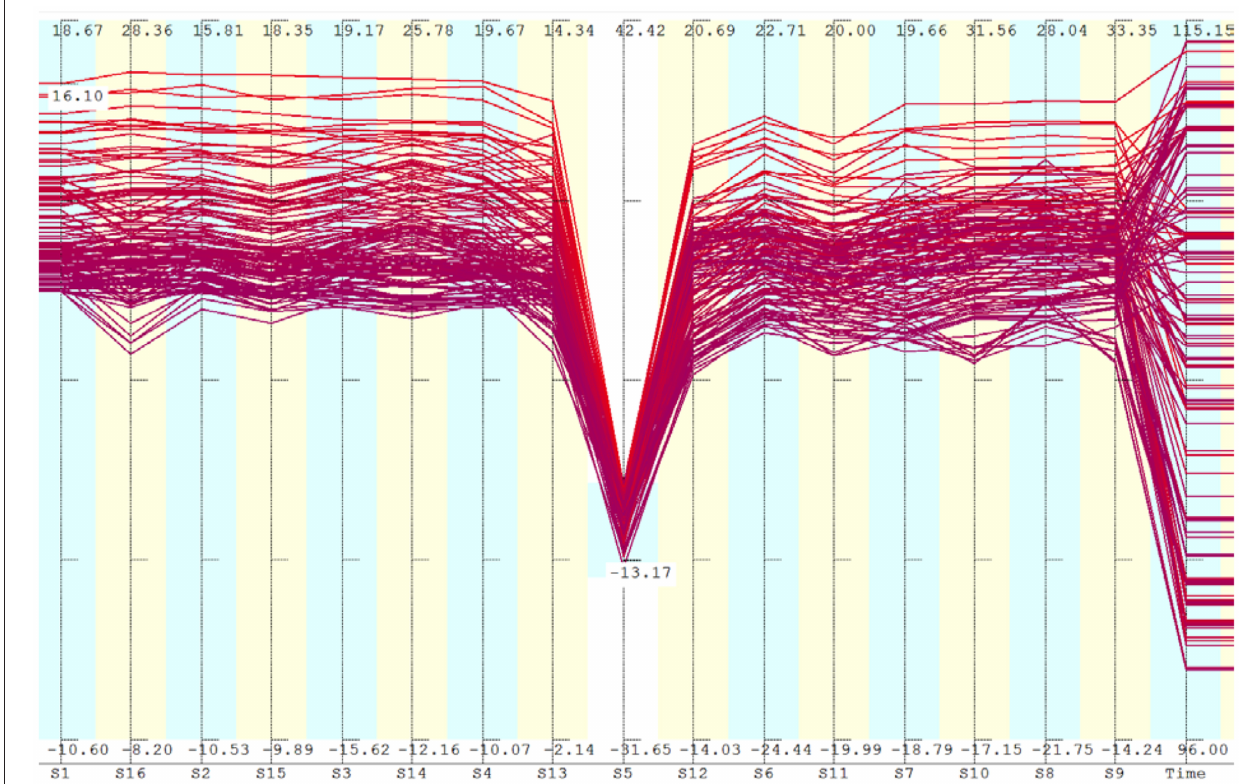
FIGURE 9 | Free vibrations after the train has left the span. Only points having large negative value of S5 are shown. Comparing with Figure 4A , similar patterns are